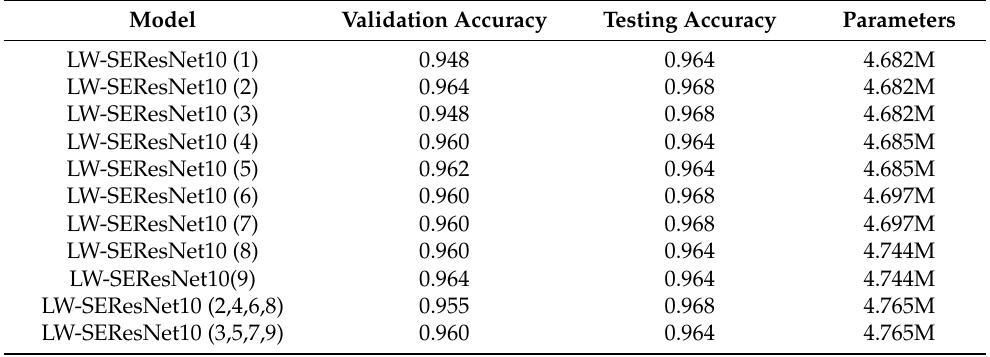
Table 2. The effect of the position of the attention mechanism on model accuracy and parameters.